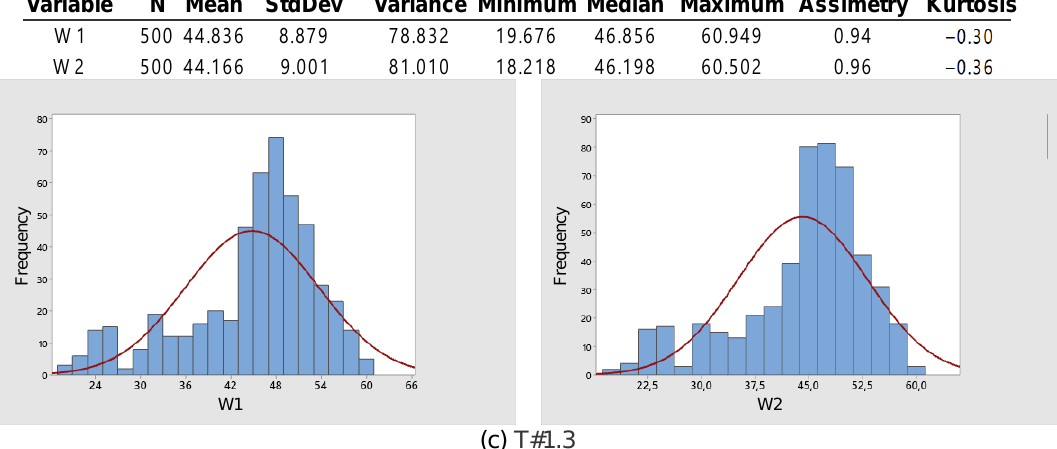
Figure 16. Basic descriptive statistics applied to data obtained during the trial sessions carried out on firm soil and without slip control.